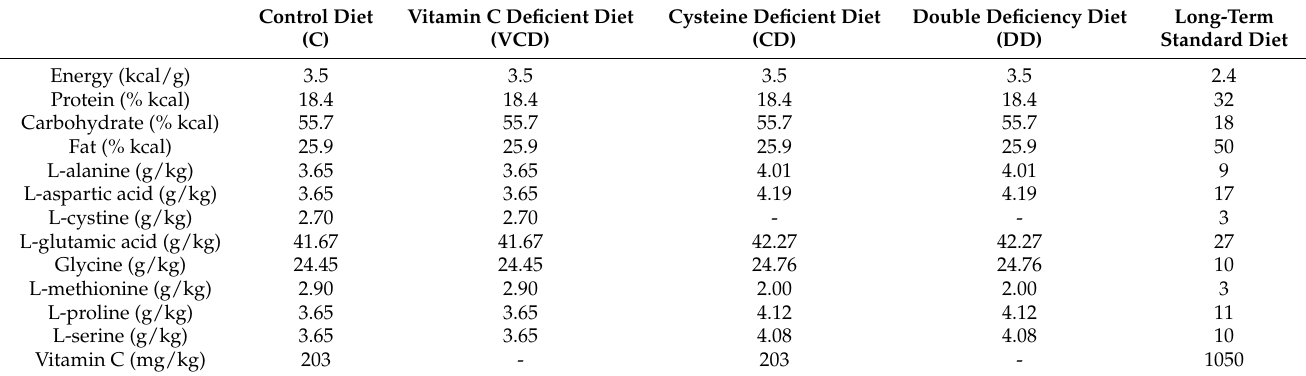
Table 1. Nutritional composition of diets used in the